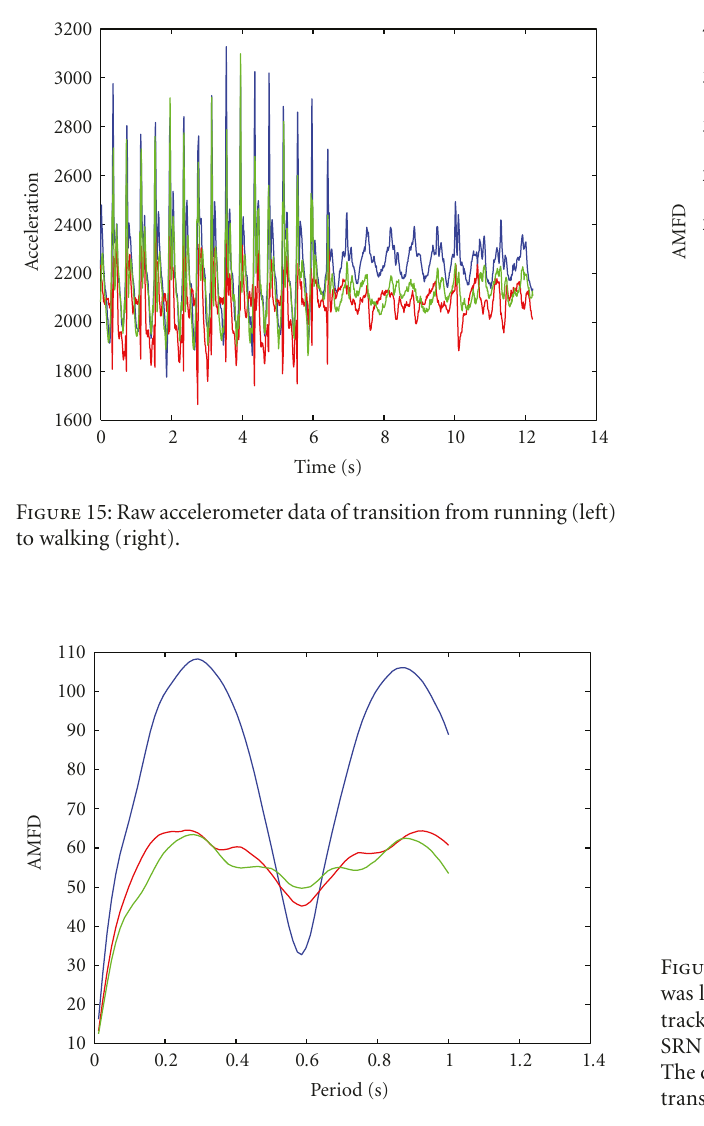
Figure 16: AMDF of accelerometer data during walking.